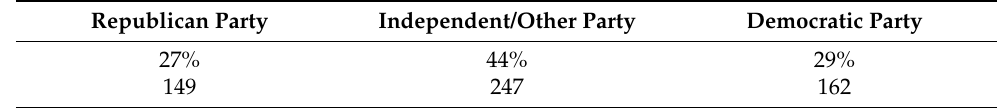
Table 5. Respondents’ political affiliation distribution [20].